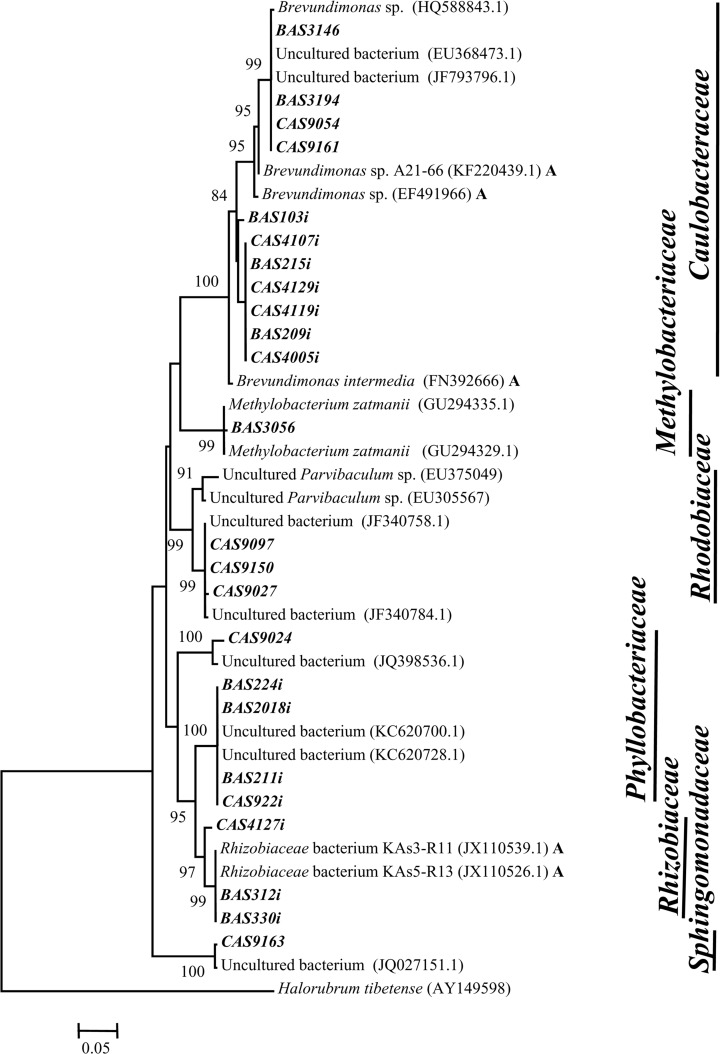
Neighbor-joining phylogenetic tree of α-Proteobacteria.The tree is based on 16S rRNA gene sequences by using Jukes-Cantor distances. 1000 bootstraps analyses are conducted and more than 50% are denoted in nodes. Sequences retrieved from As contaminated environment are suffixed as ‘A’. Sequences represented in bold italic font are derived from clone libraries and bold italic font with a suffix ‘i’ are derived from isolated strains.